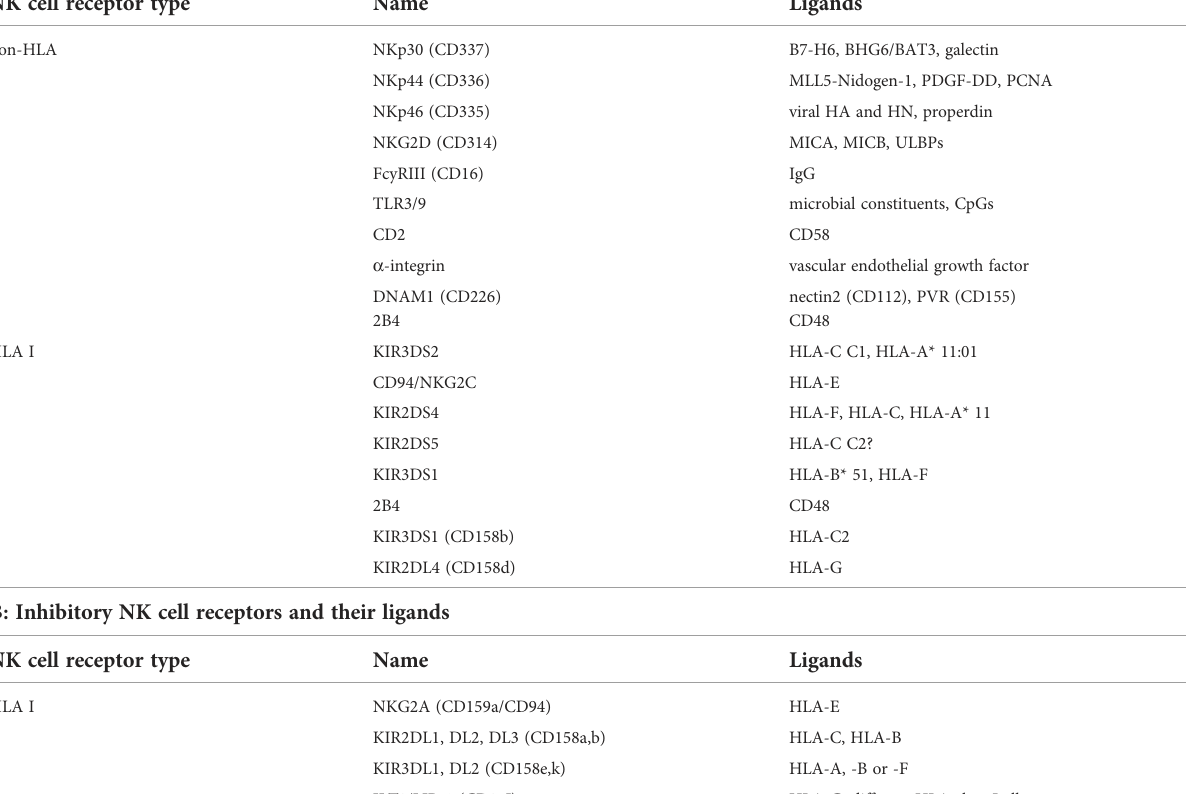
TABLE 1 Major NK cell receptors and their ligands. A: Activating NK cell receptors and their